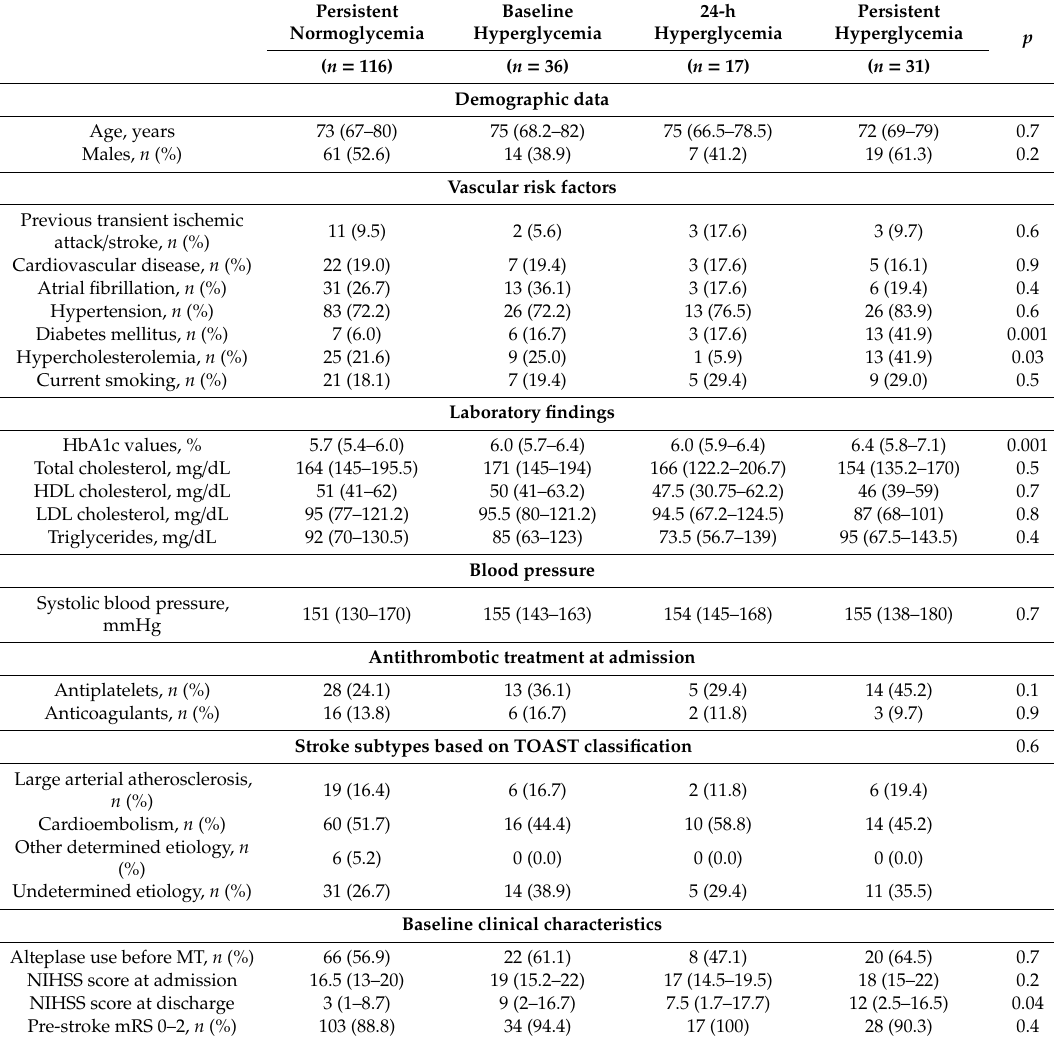
Table 1. General characteristics of the subjects according to the hyperglycemic